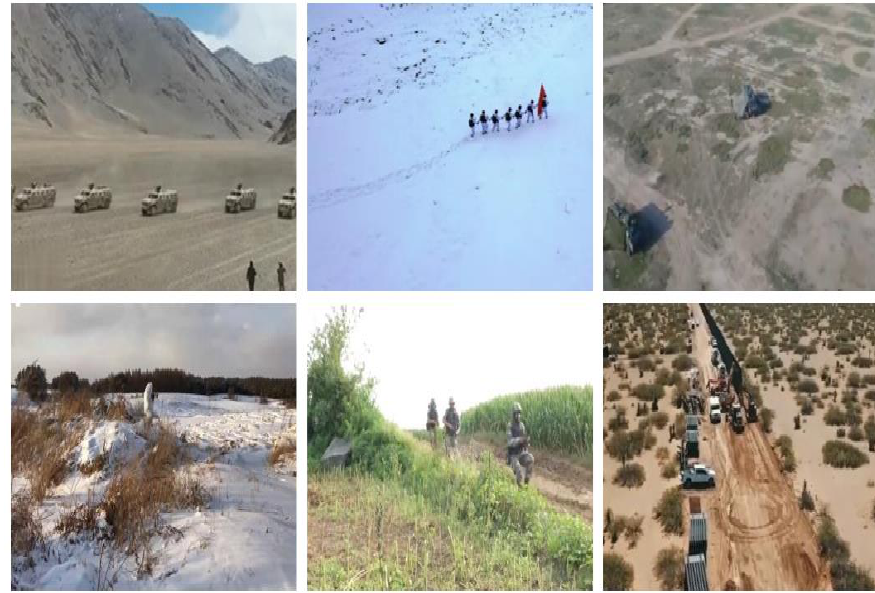
Figure 5. Sample images from the BDP dataset.